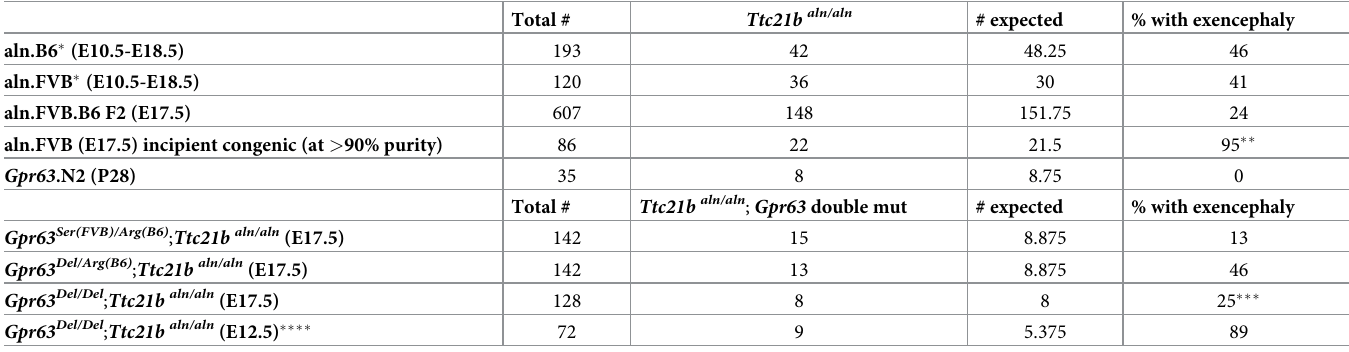
Table 1. Mutant genotype and exencephaly